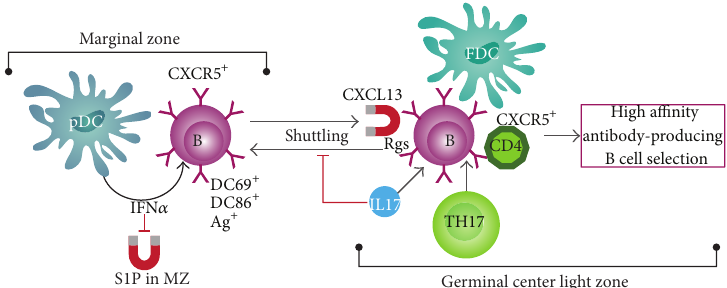
Figure 4: Chemotactic responses play a key role in orchestrating the cell-cell interactions in the germinal centers.